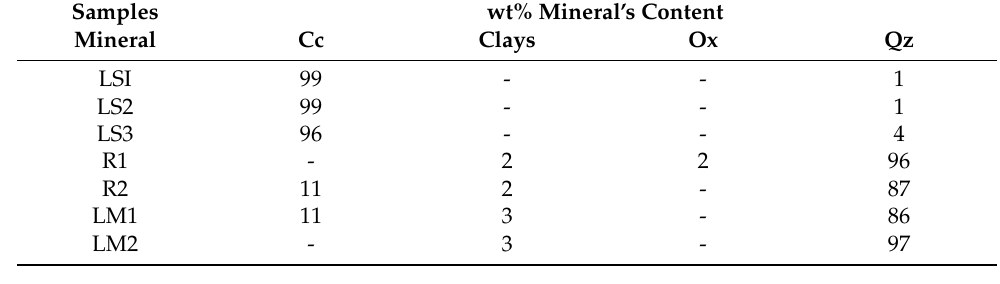
Table 5. Mineral composition of studied rock materials. Abbreviations: Cc: calcite; Ox: oxides; Qz: quartz; and (-): not detected.